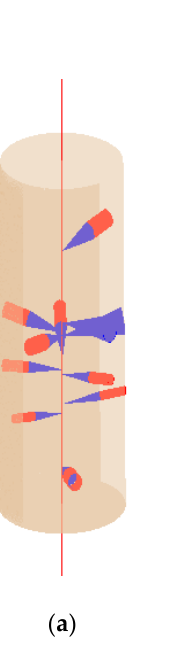
Table 2. Measured information of the first log branches.